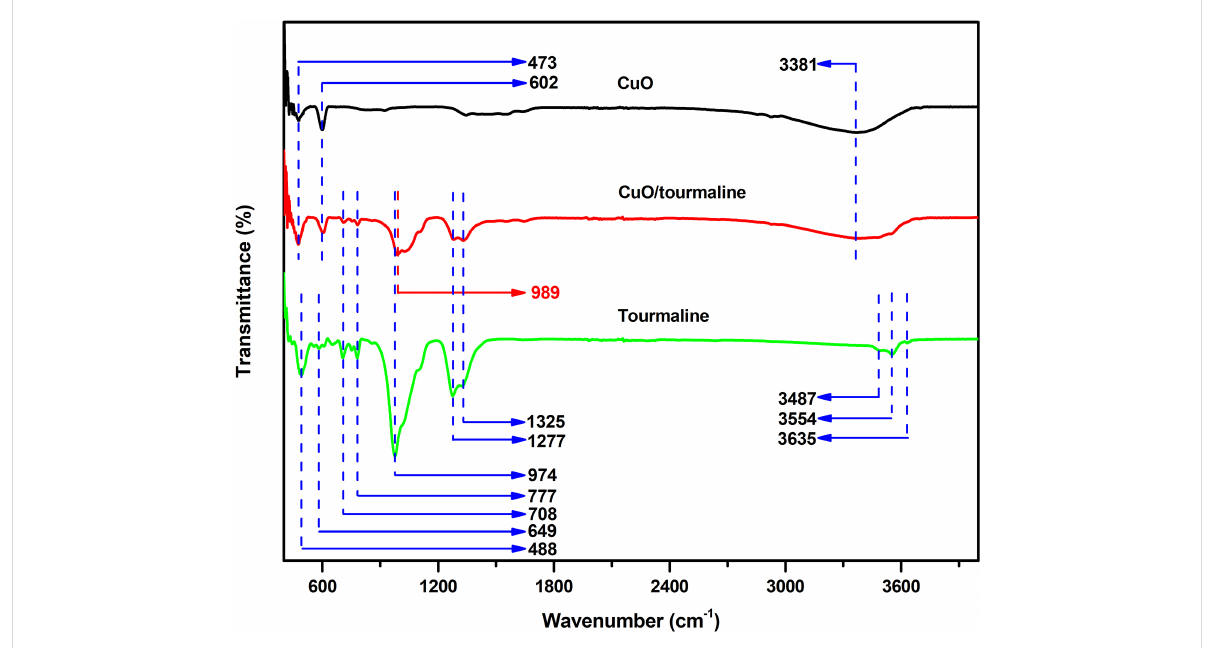
Figure 2: FTIR spectra of the CuO, tourmaline, and CuO/tourmaline composite.